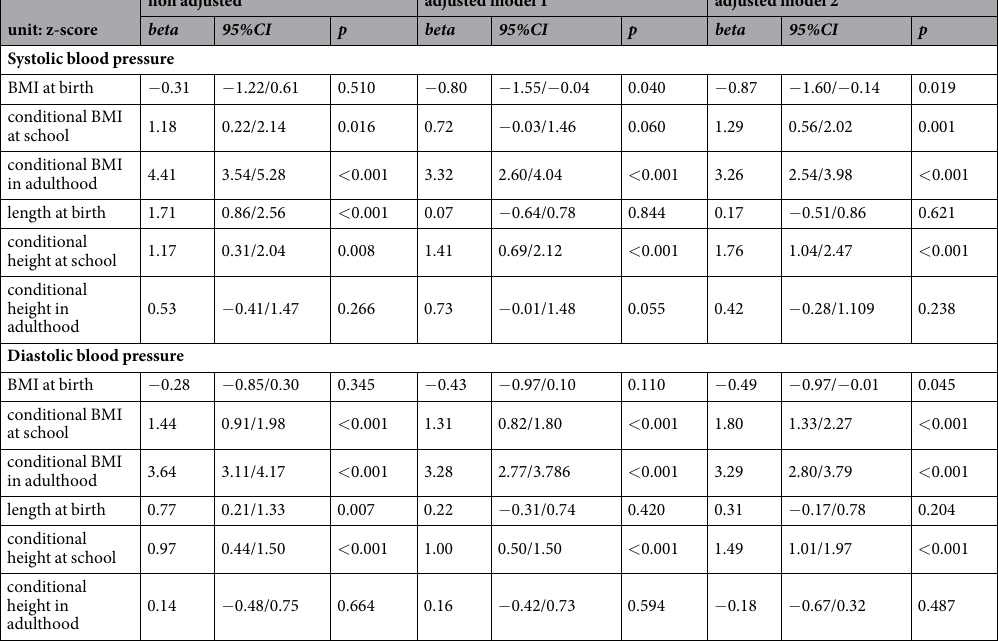
Table 6. Linear regression of the association between growth patterns and systolic and diastolic blood pressure in a population–based birth cohort born in Brazil (N = 1141). Unadjusted model: each anthropometric measure entered into a separate model. Model 1 BMI and length/height entered into separate models that were adjusted for gender, type of delivery, gestational age, maternal hypertension, adult smoking, adult age and occupation of the head of the family in adulthood. Model 2 BMI and length/height were adjusted for each other and for gender, type of delivery, gestational age, maternal hypertension, adult smoking, adult age and occupation of the head of the family in adulthood. 95%CI = 95% confidence